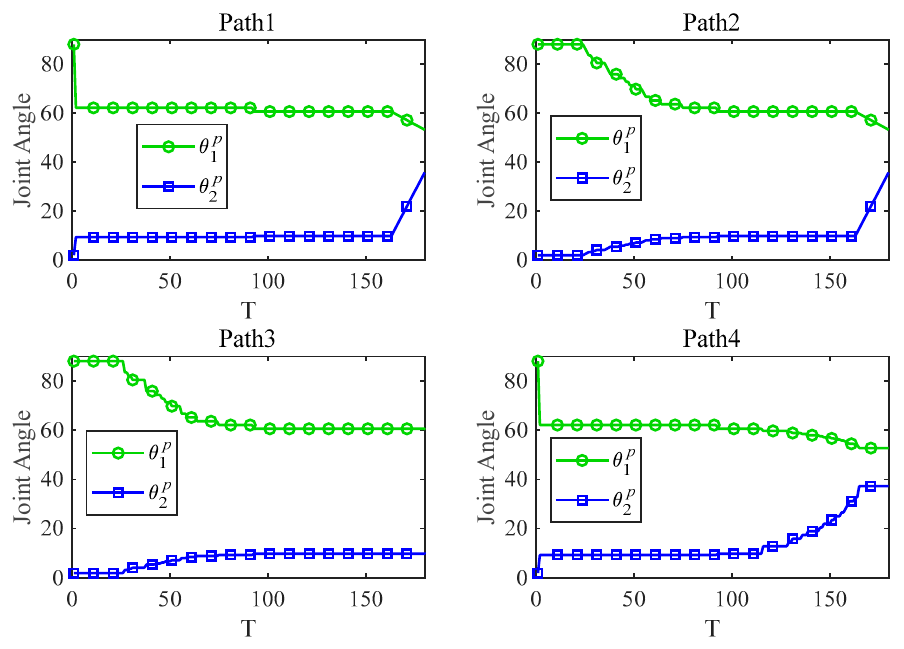
Figure 23. Angle curves of planned joints under four collision-free paths.